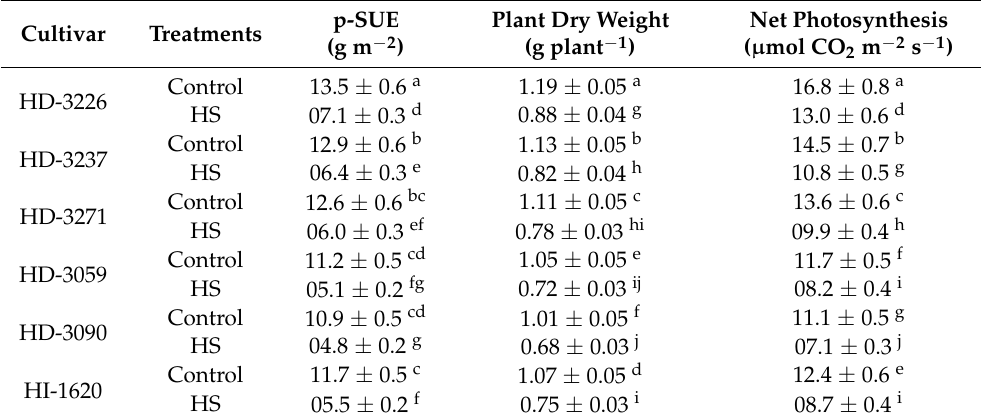
Table 1. Photosynthetic sulfur use efficiency (p-SUE), plant dry weight and net photosynthesis of wheat ( Triticum aestivum L.) cultivars HD-3226, HD-3237, HD-3271, HD-3059, HD-3090 and HI-1620 grown in the presence or absence of heat stress (HS; 40 ◦ C for 6 h daily for 15 days) at 30 days after germination.